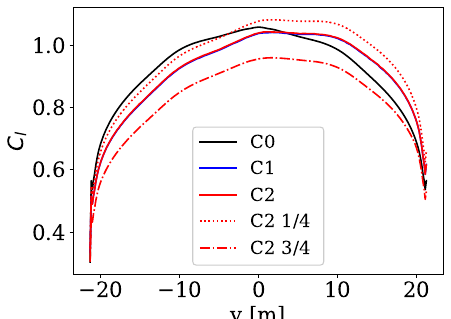
Figure 15. Spanwise lift distribution (last loop), with 1/4 meaning the highest altitude and 3/4 meaning the lowest